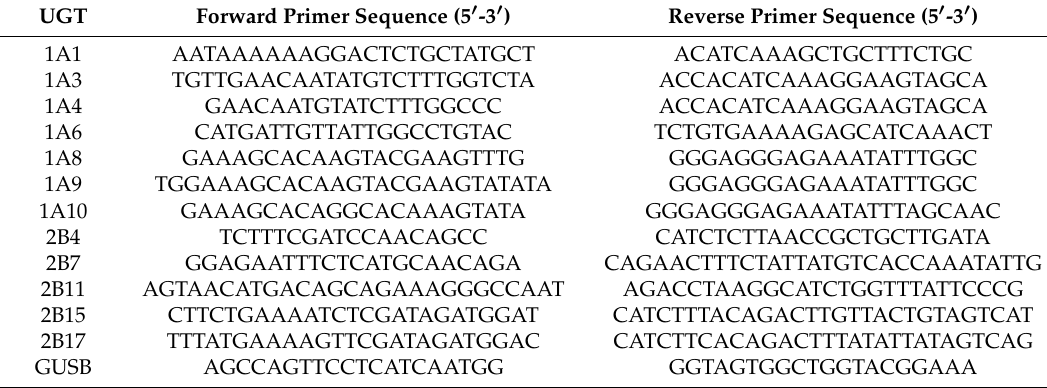
Table 1. Uridine 5 (cid:48) -diphosphate-glucuronosyl transferases (UGT) primer sequences used to produce quantitative polymerase chain reaction (qPCR) results for gene expression analysis. The isoform examined, forward and reverse primer sequences, as well as publication source (reference number) are listed. Primers were from references. GUSB: